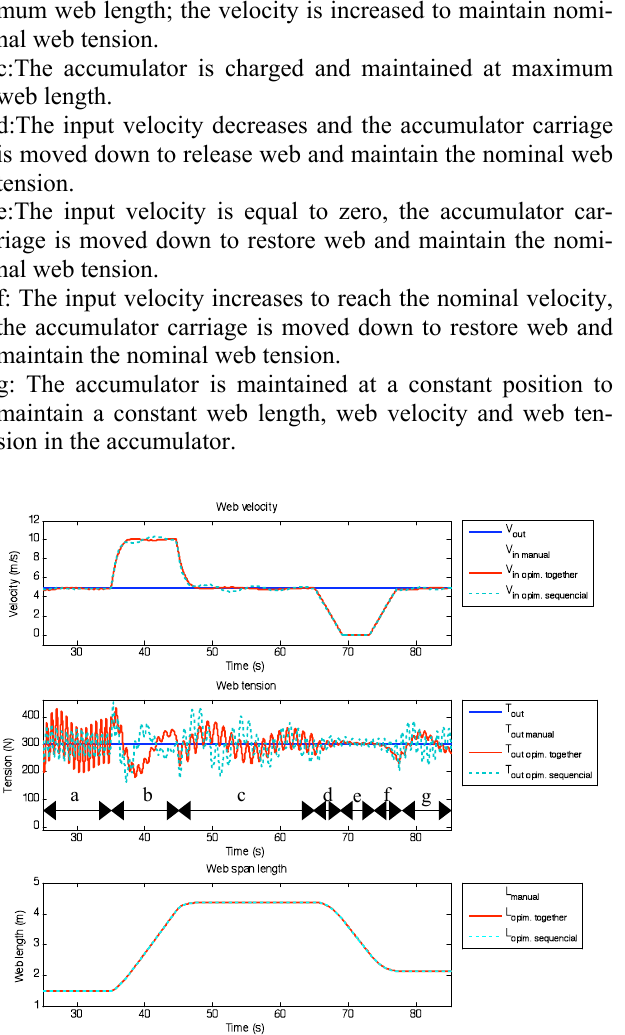
Fig.13. Optimized PI controllers simulation results using cost function for switching strategy